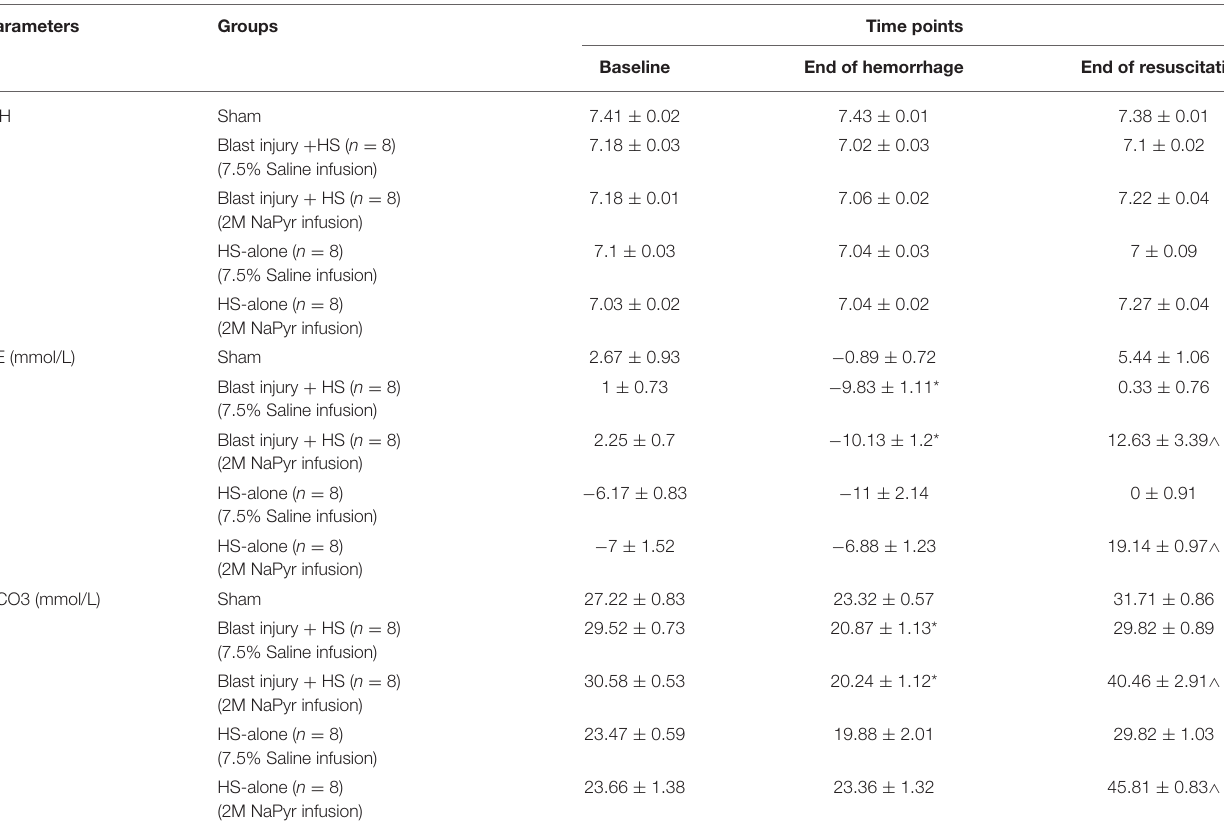
TABLE 1 | Acid–base balance in mean ± SE.